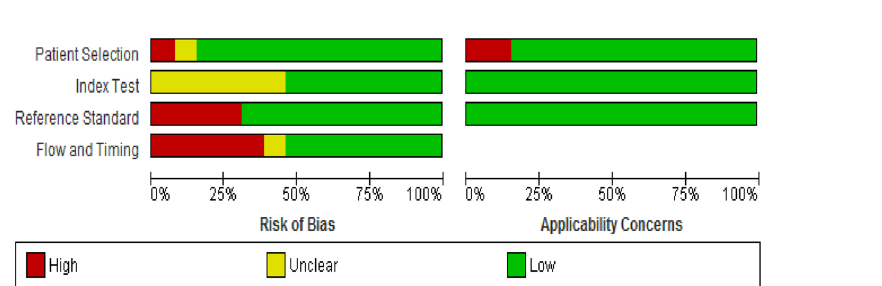
Figure 1. Study selection.